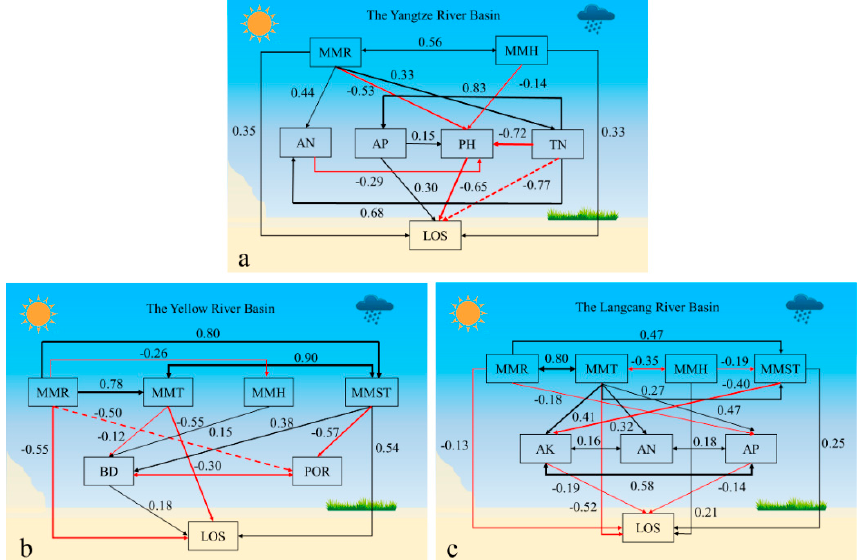
Figure 7. Mechanisms involved in the patterns of the length of the plant growing season in different basins. Structural equation modeling (SEM) was used to analyze the total effects of variables. The black and red solid lines represent positive and negative standardized SEM coefficients, respectively, while the line thickness indicates the magnitude of these coefficients for the Yangtze ( a ), Yellow ( b ), and Lancang ( c ) river basins, respectively. MMR, MMT, MMH, and MMST represent monthly mean shortwave radiation, temperature, relative humidity, and soil temperature, respectively. AN, AP, pH, TN, BD, POR, and AK represent alkali-hydrolysable N, available P, pH (H 2 O), total N, bulk density, porosity, and available K, respectively.